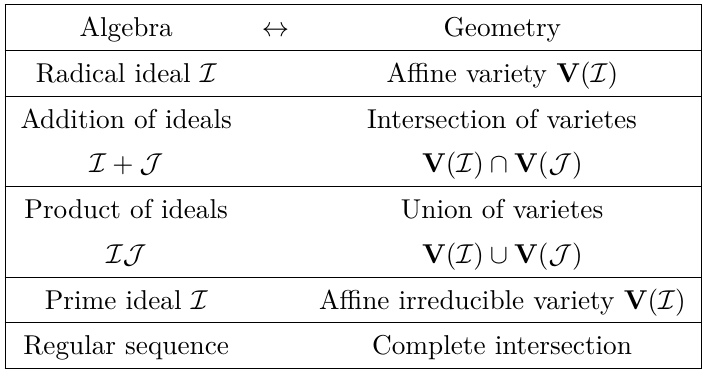
Table 11. Summary of the algebra-geometry